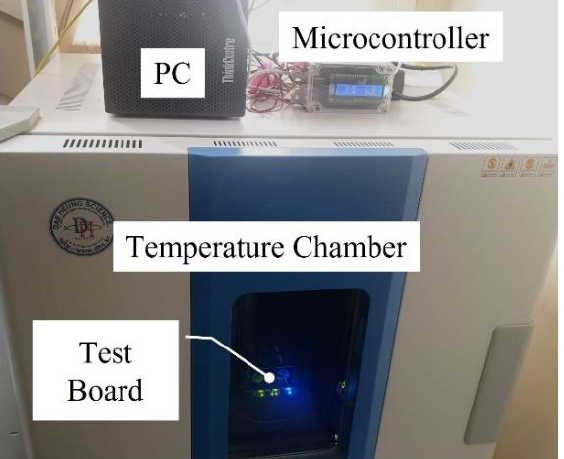
Figure 7. Temperature control environment with a temperature chamber, a microcontroller, and a computer (development kit is inside the chamber).